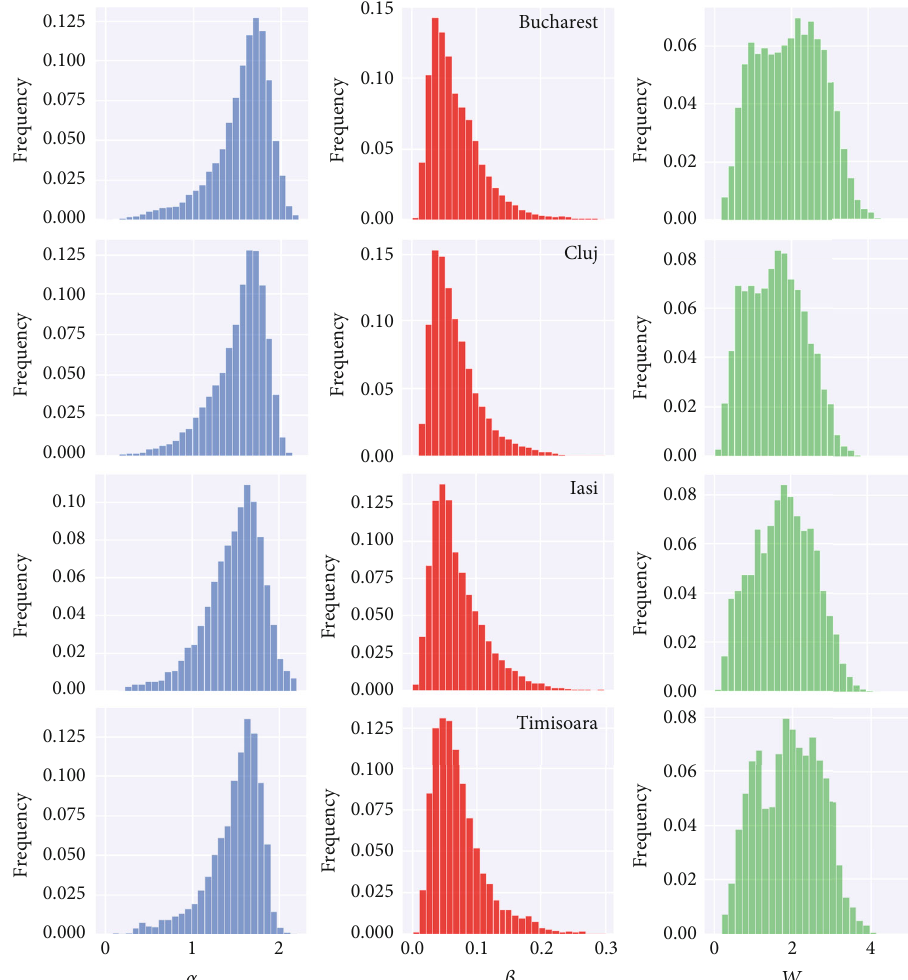
Figure 3: Distribution of the Ångström exponent α , Ångström turbidity coe ffi cient β , and water vapor column content w (g/cm 2 ) measured at the AERONET stations: Bucharest, Cluj, Iasi, and Timisoara during January 2012 to December 2020. For each physical quantity, the total number of recordings is 162722 broken down on stations as follows: 64248 at Bucharest, 34689 at Cluj, 39340 at Iasi, and 24445 at